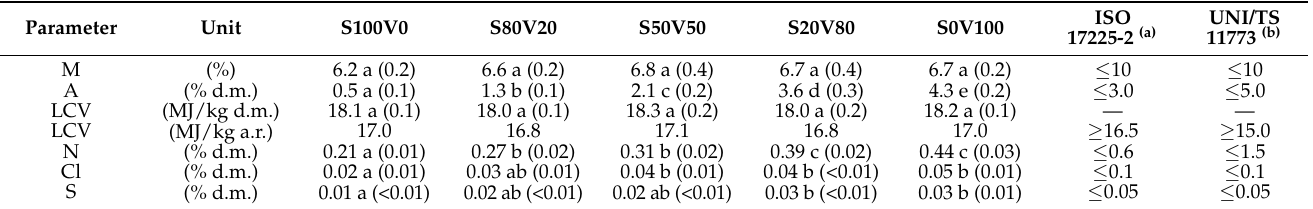
Table 5. Results of analyses on pellets produced with the different blends of spruce sawdust and vineyard pruning residues (average values with standard deviation in